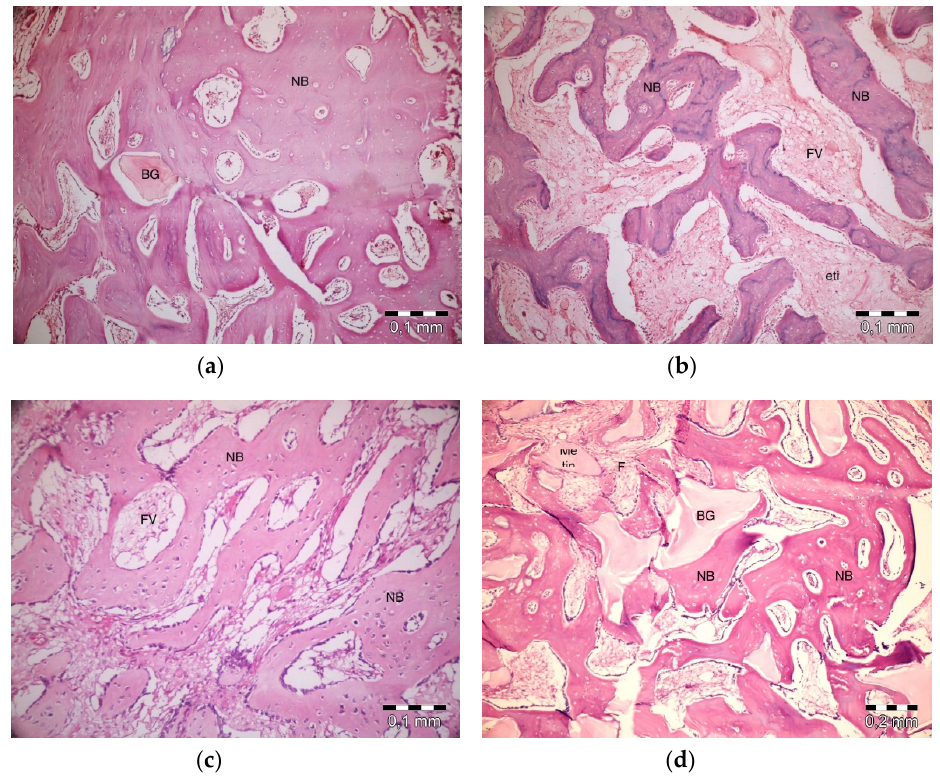
Figure 5. Histologic findings on 40 th day. ( a ): PRF + ABB; ( b ): PRF; ( c ): Empty Defect; ( d ): ABB + CM. N: New bone area; F: Fibrosis; BG: Bone graft; DW: Defect wall; CB: Compact bone; BM: Bone marrow; FV: Fibrovascular area.